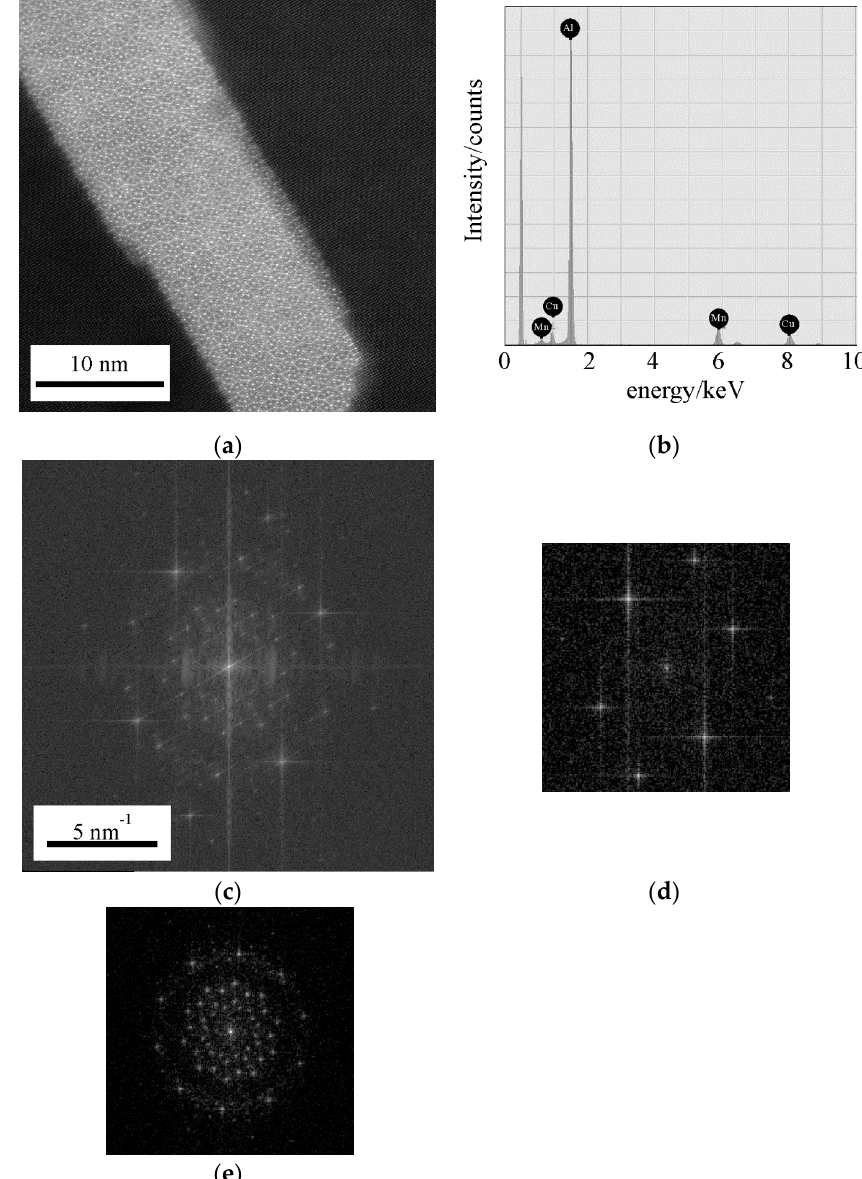
Figure 8. A decagonal quasicrystalline (DQC) precipitate in Al 95.4 Mn 1.8 Cu 1.6 Be 1.2 after ageing at 400 °C for 1 h. ( a ) A high-resolution scanning transmission electron image, taken with a HAADF detector (High-angle Annular Dark Field), ( b ) an EDS spectrum of the IQC particle, ( c ) FFT of the entire area, ( d ) FFT of Al-rich matrix, with the zone axis [001], ( e ) FFT of the DQC particle along its tenfold axis.